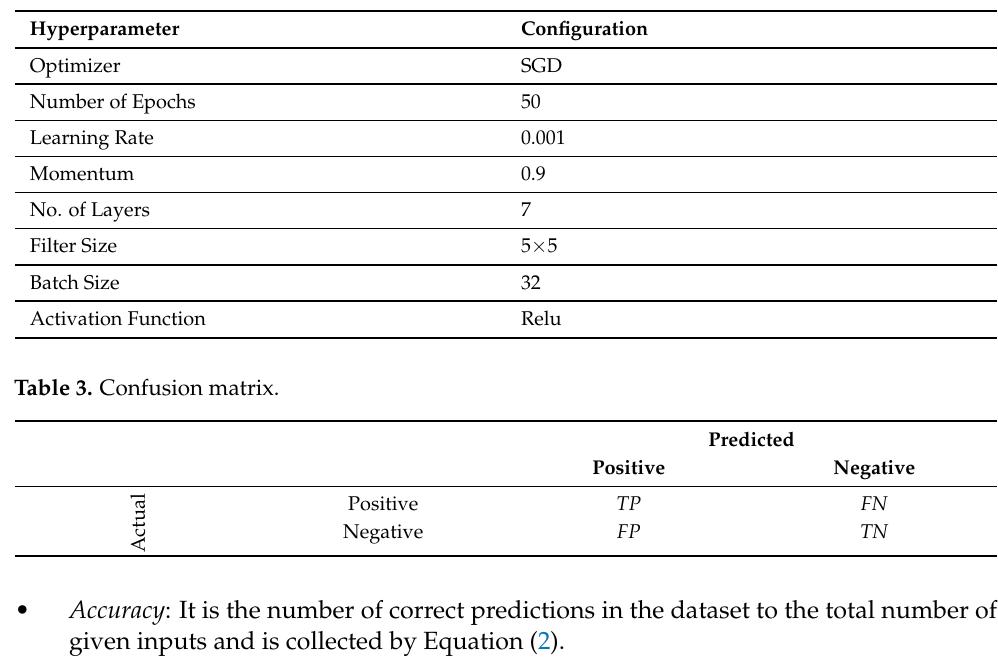
Table 2. Hyperparameter configuration after performing the optimization for brain-tumor detection.